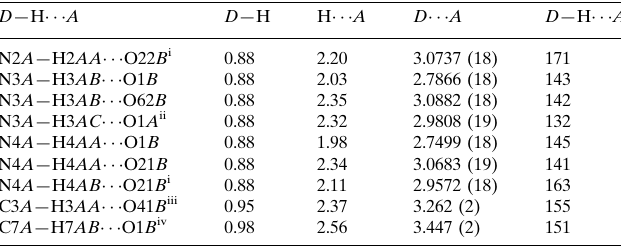
Hydrogen-bond geometry (A˚ , (cid:4) ). D —H (cid:2)(cid:2)(cid:2)